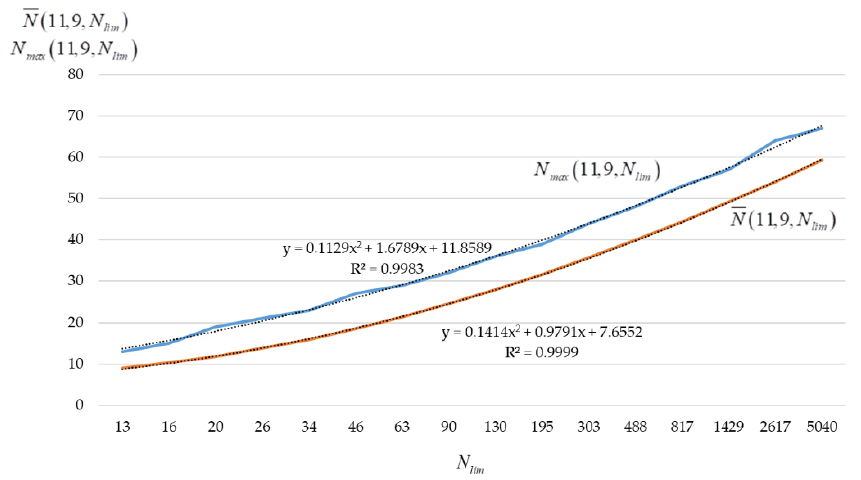
Figure 11. Graphs N ( 11,9, N lim ) and N max ( 11,9, N lim ) when ∆ = 0.08.